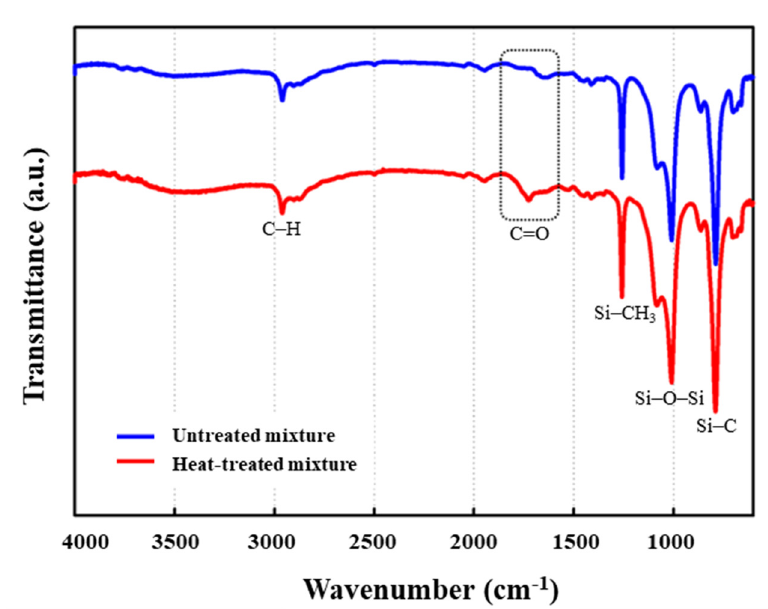
Figure 7. FTIR spectra of a mixture of amino silicone softener and blocked isocyanate before (blue color) and after (red color) drying at 150 °C for 30 min.